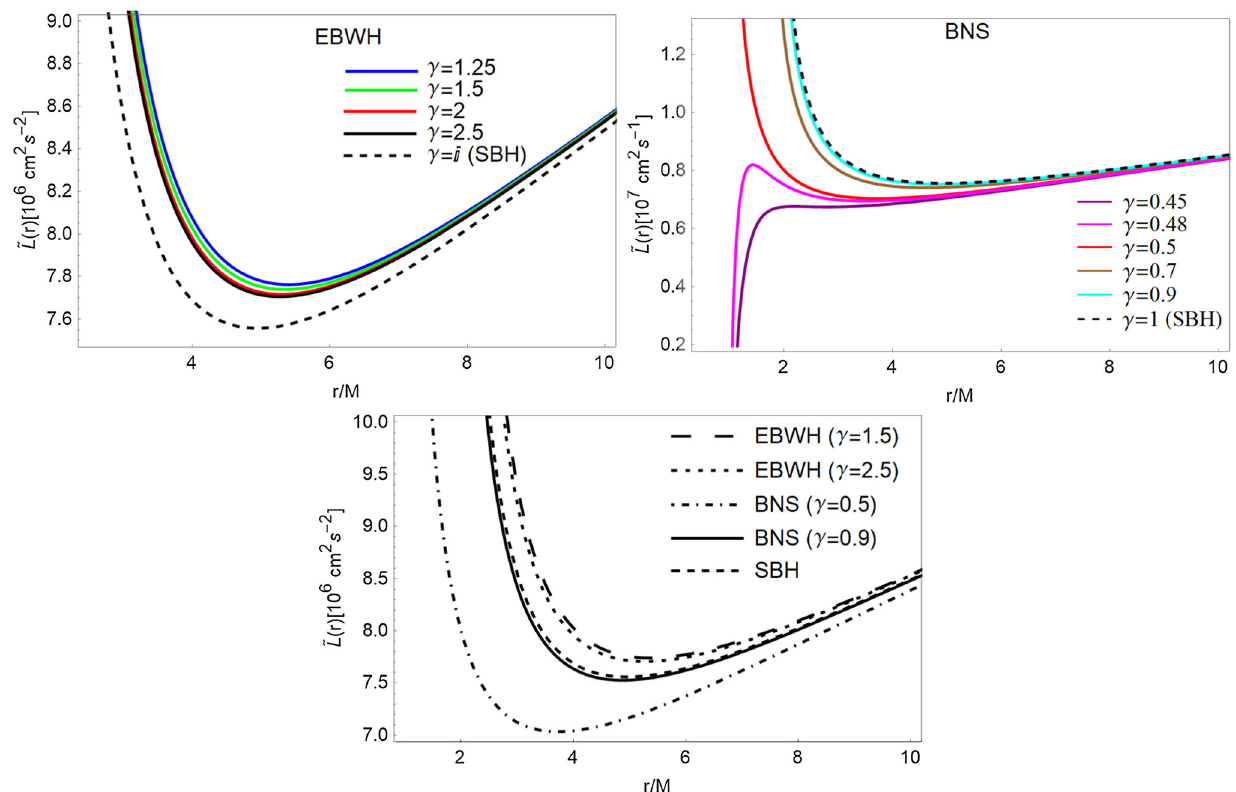
Fig. 4 The specific angular momentum (cid:11) L ( r ) for EBWH, BNS and SBH for different values of γ